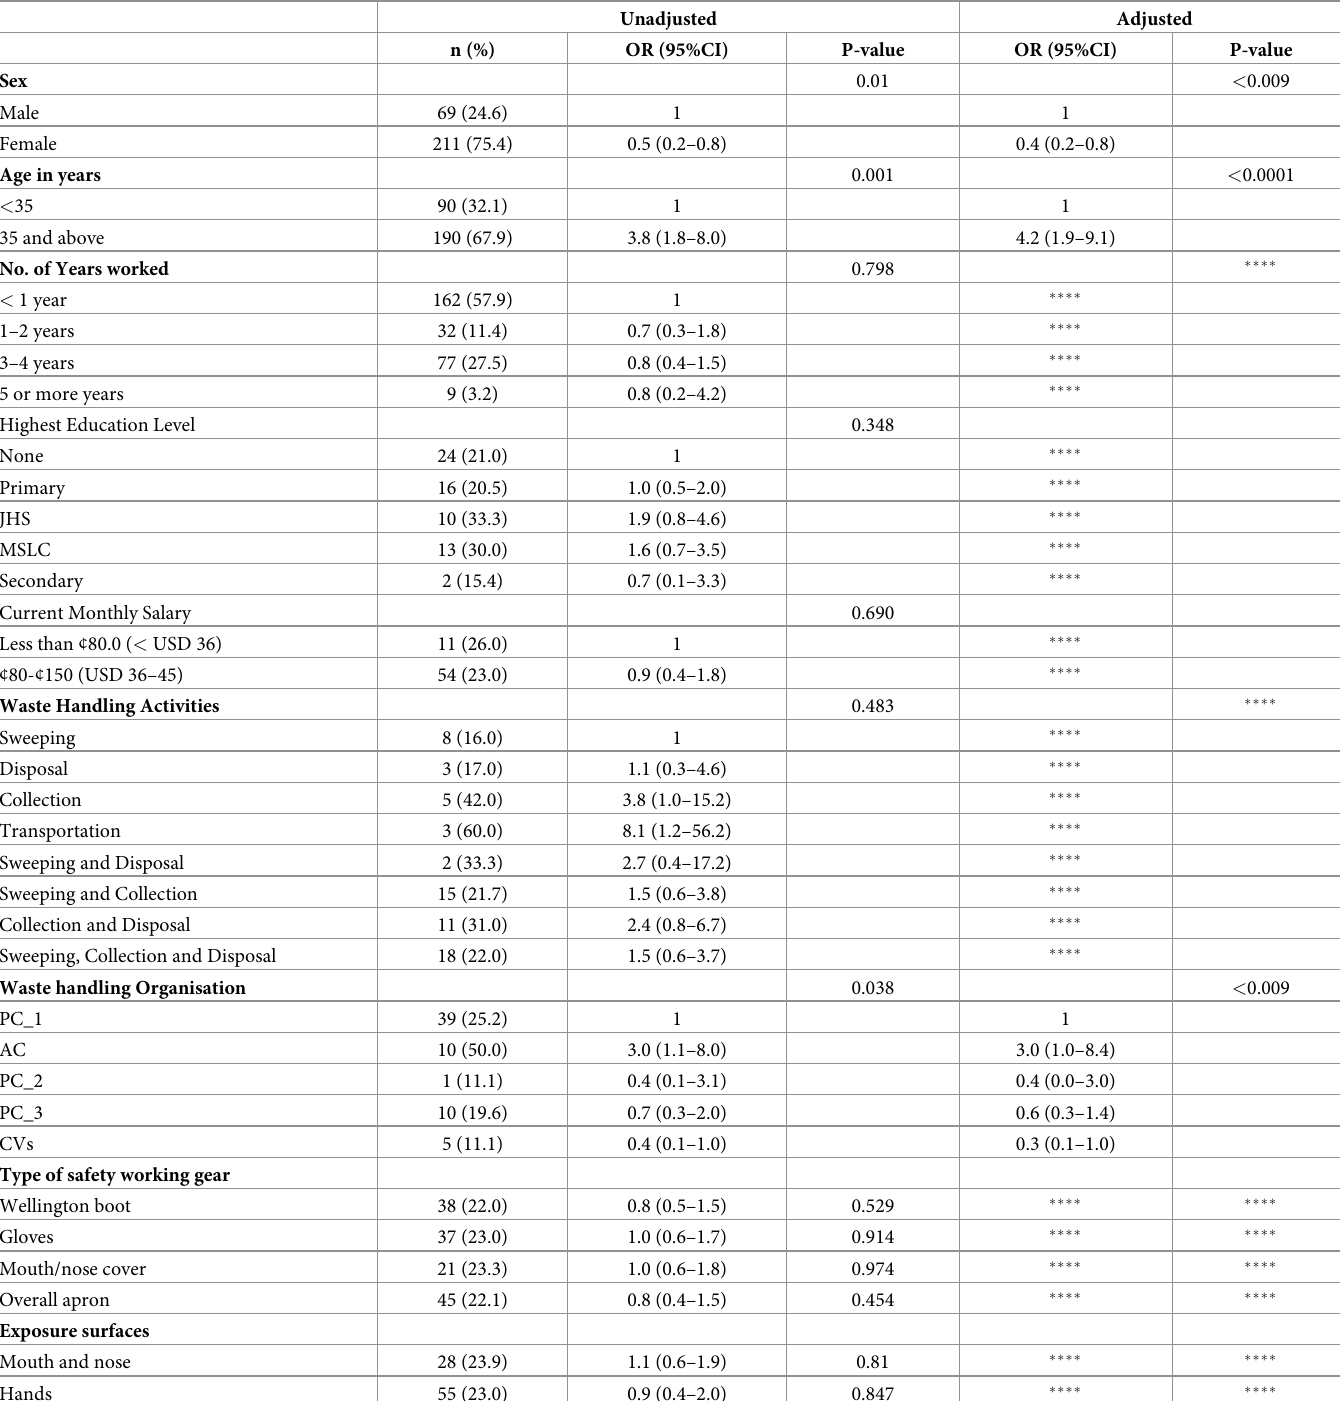
Table 4. The effect of socio-demographic factors and other determinants on detection of faecal indicator E . coli